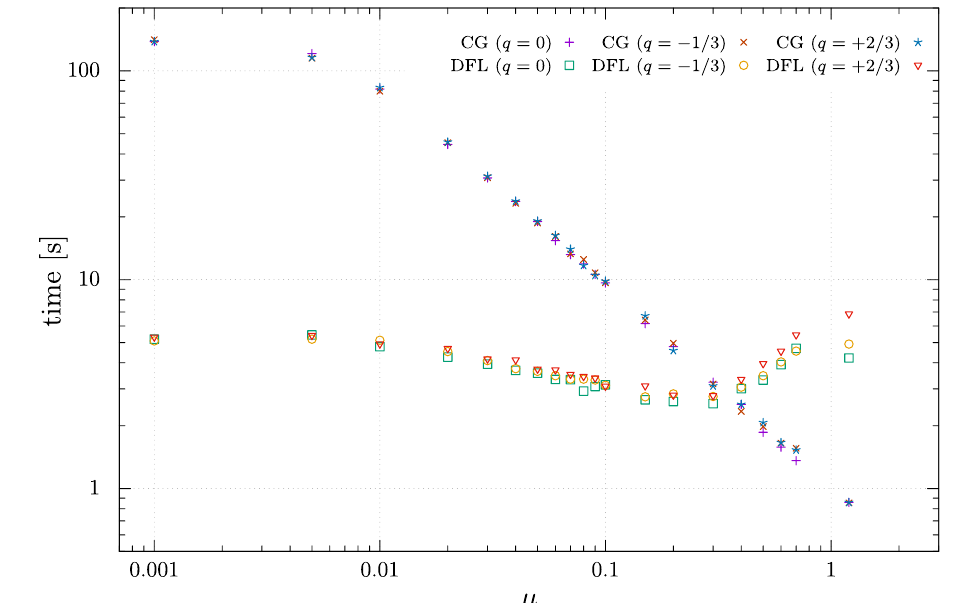
Fig. 7 Comparisonofperformanceofvarioussolversandvariouselec- tric charges as a function of the twisted mass μ . In all cases, the inverse of ( ˆ D † ˆ D + μ 2 ) has been calculated on random sources. The mass of the valence neutral pion (calculated at μ = 0) has been chosen to be m PS (cid:7) 329MeV. One representative QCD+qQED configuration has been used (SU(3) configuration from the QCD1 ensemble, Table 1, and